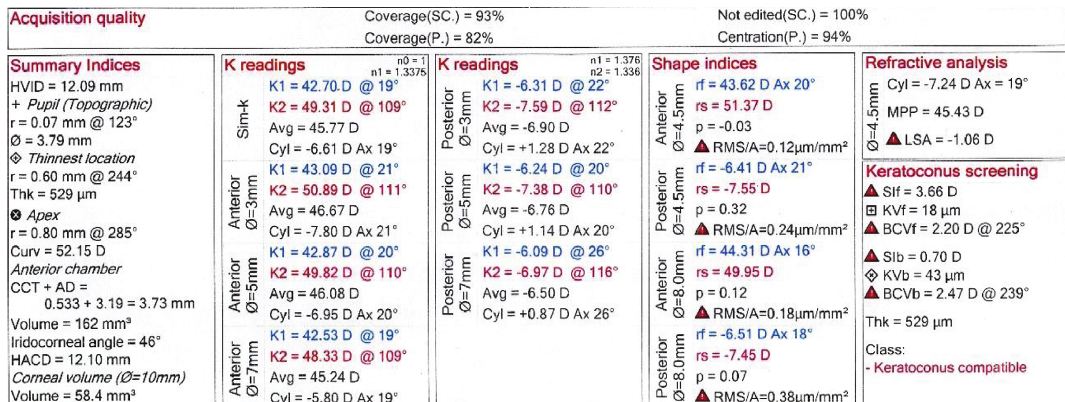
Figure 3: Two years post-CXL Sirius quad map of the same eye. At 2 years after treatment, the preoperative values of flat, steep, and mean keratometries decreased from 42.83D, 50.48D, and 46.34D, respectively, to 42.70, 49.31, and 45.77, respectively, while the anterior maximum keratometry (curve apex) decreased from 53.33D to 52.15D. The minimum corneal thickness increased from 520um to